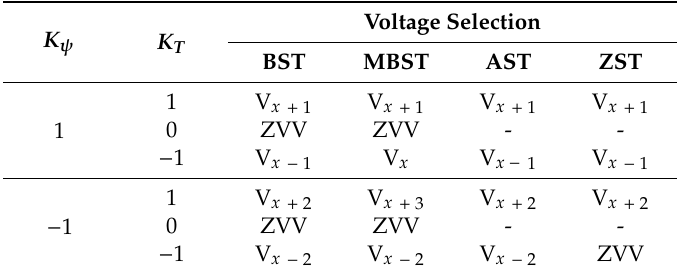
Table 1. Voltage selection of the conventional